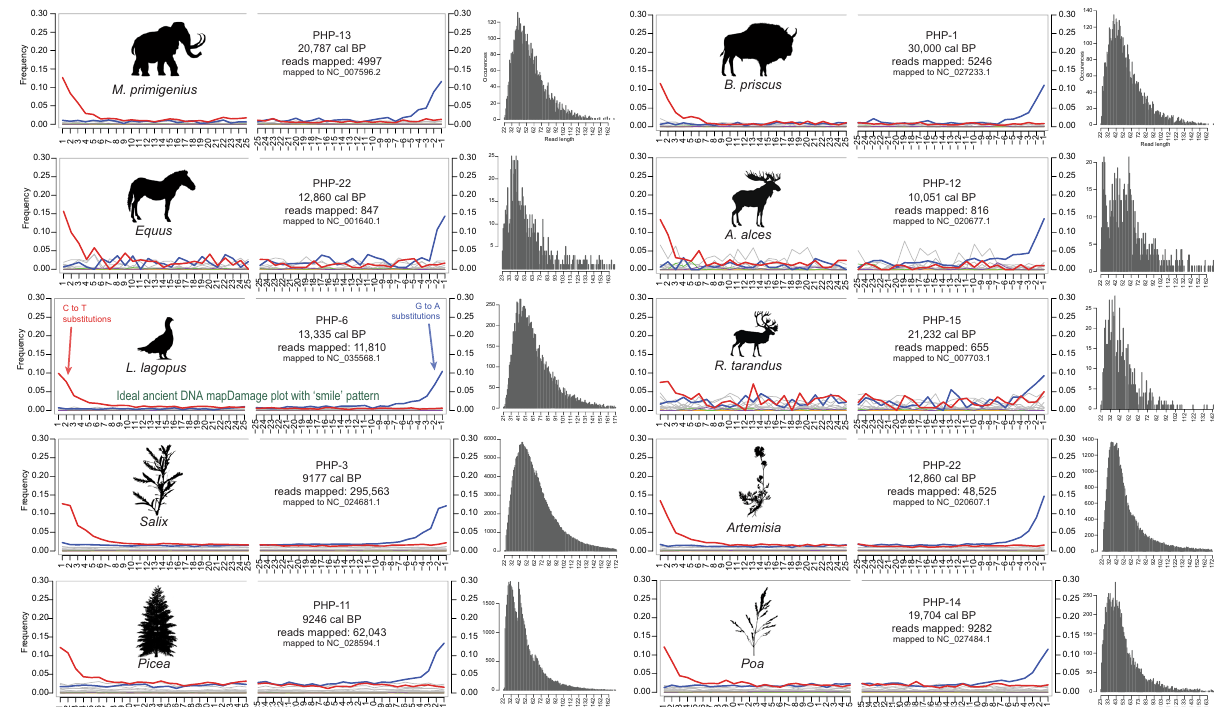
Fig. 5 Example mapDamage plots. Minimum size 24 bp, minimum map quality 30. See Supplementary Figs. 13 – 28 for a full breakdown of fragment misincorporation plots and a discussion of on/off target mapping. Source data are provided as a Source Data fi le.